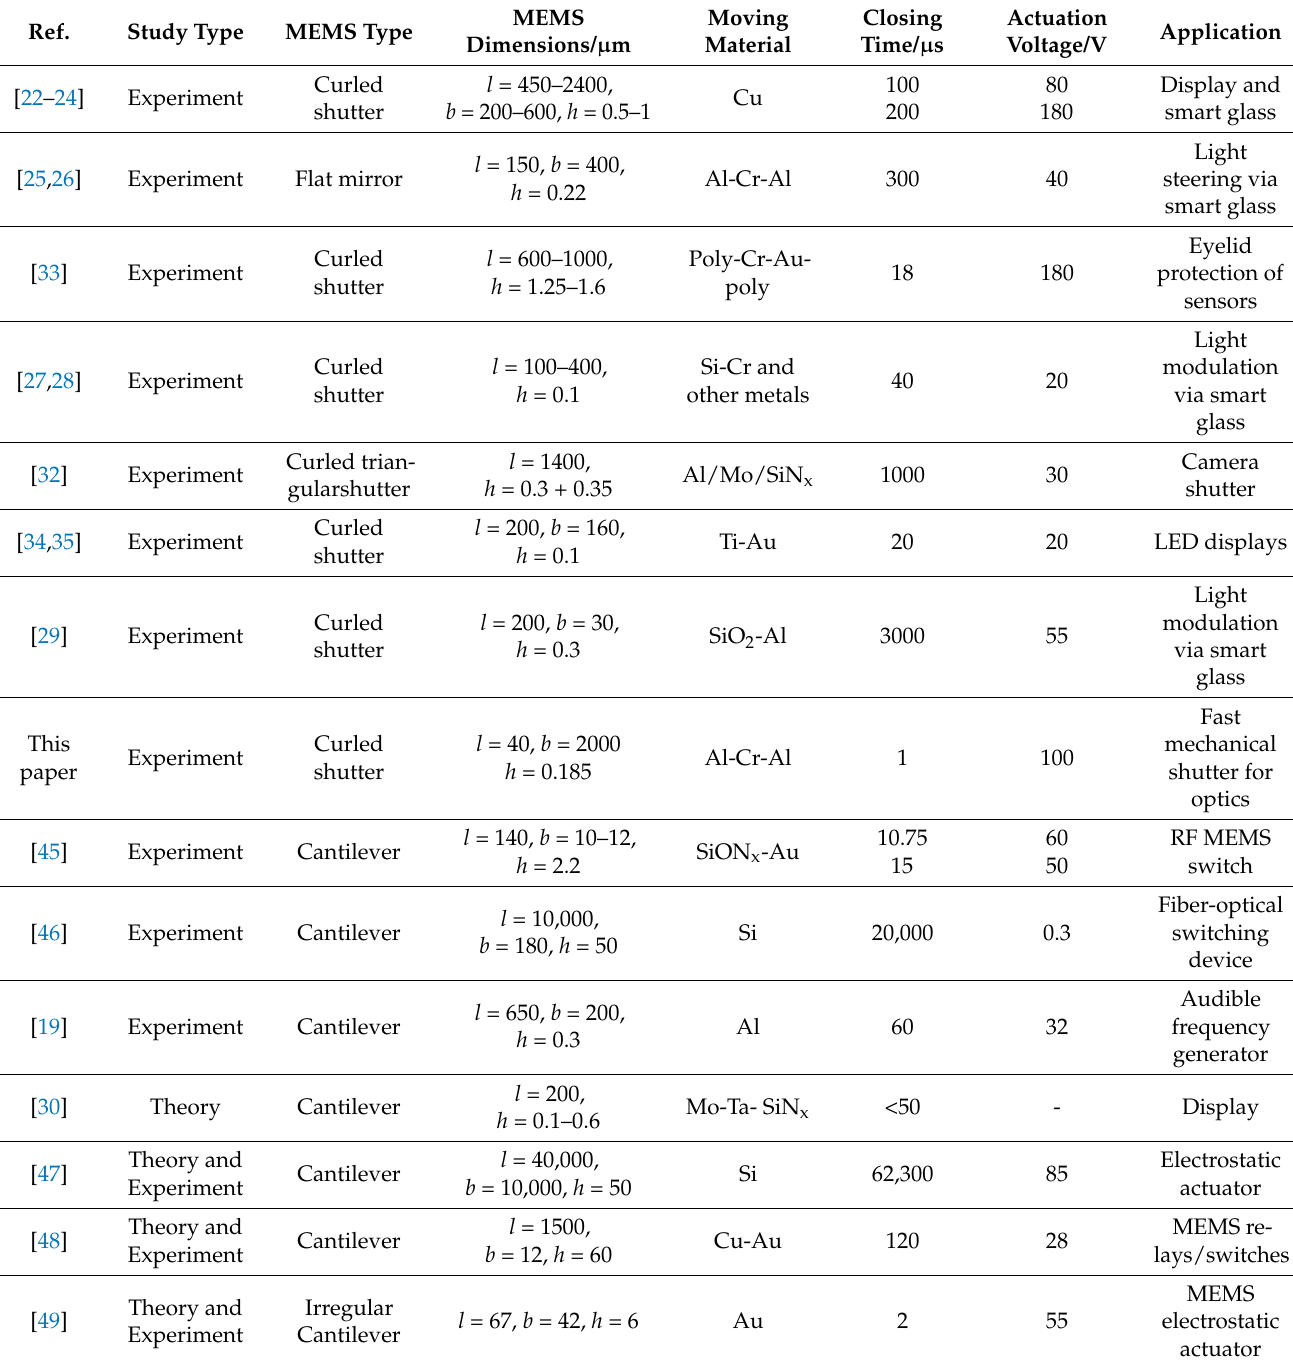
Table 4. Comparison of actuation times (here closing times) of MEMS shutters/mirrors/cantilevers. The type of the study is experimental or theoretical. The dimensions are given as long they are available from the literature. The dimensions are denoted as in this paper: length l , width b and thickness h . For the top electrode, which is moving, materials and dimensions are given. The type of the study is experimental or theoretical or